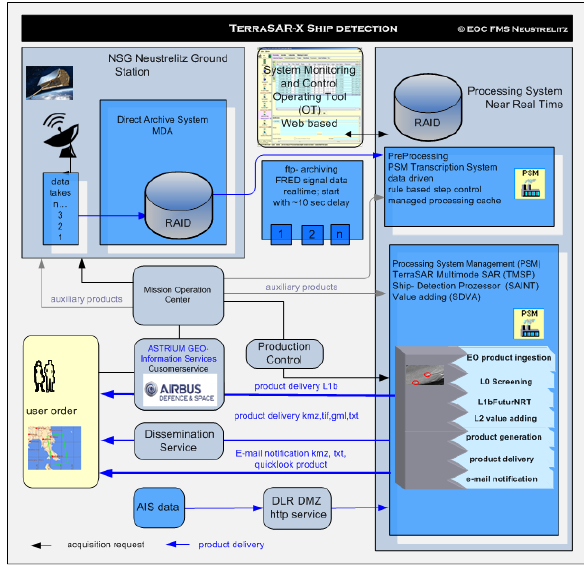
Figure 3. TerraSAR-X NRT ship detection